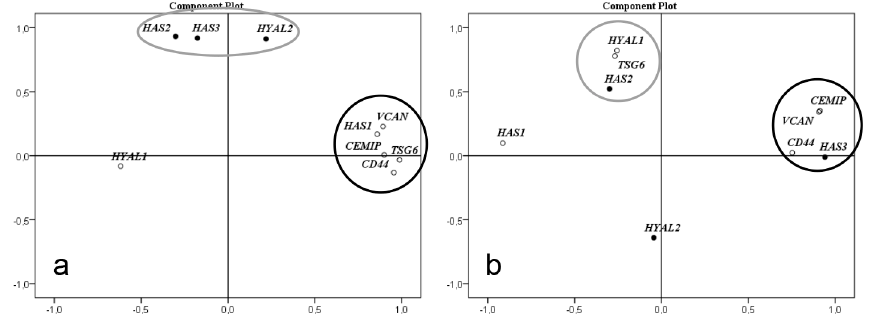
Figure 3. Factor analysis for correlation of gene expression levels. HAS1-3, HYAL1-2, CEMIP , CD44, VCAN , and TSG6 in non-failing left wall and septum (n = 9) ( a ) and HCM myectomies (n = 5) ( b ). ( a ) In